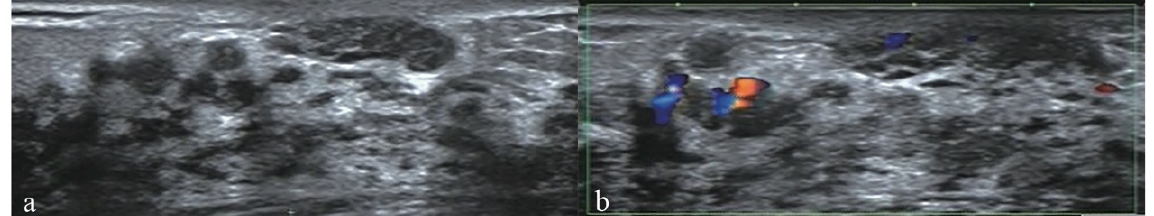
Figure 1. Conventional US images of a 45-year-old female who was diagnosed with DCIS by surgical excision. ( a ) The B-mode US image shows a 37.0 mm non-mass breast lesion with microcalcifications in the outer upper quadrant area next to the nipple of the right breast (arrows); ( b ) The color Doppler US image shows abundant blood supply.